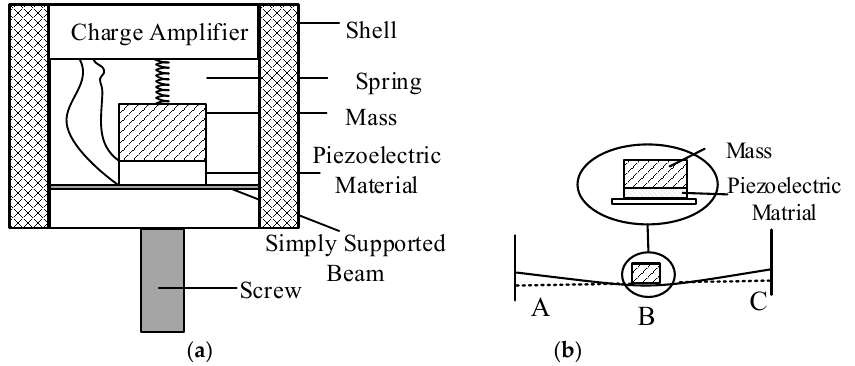
Figure 3. ( a ) The design of the piezoelectric accelerometer; ( b ) The PE transducer based on simply supported beam.